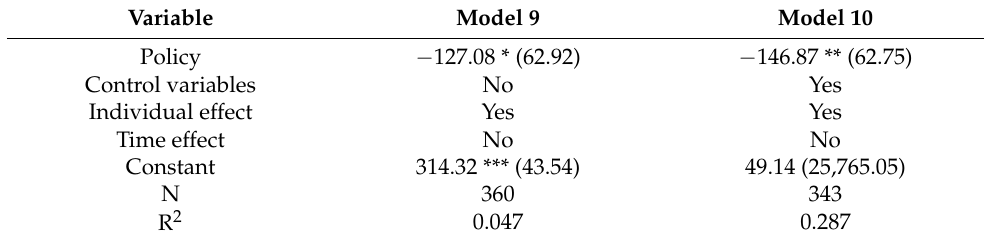
Table 6. Single difference test estimation results of the impact of the carbon emissions trading system.